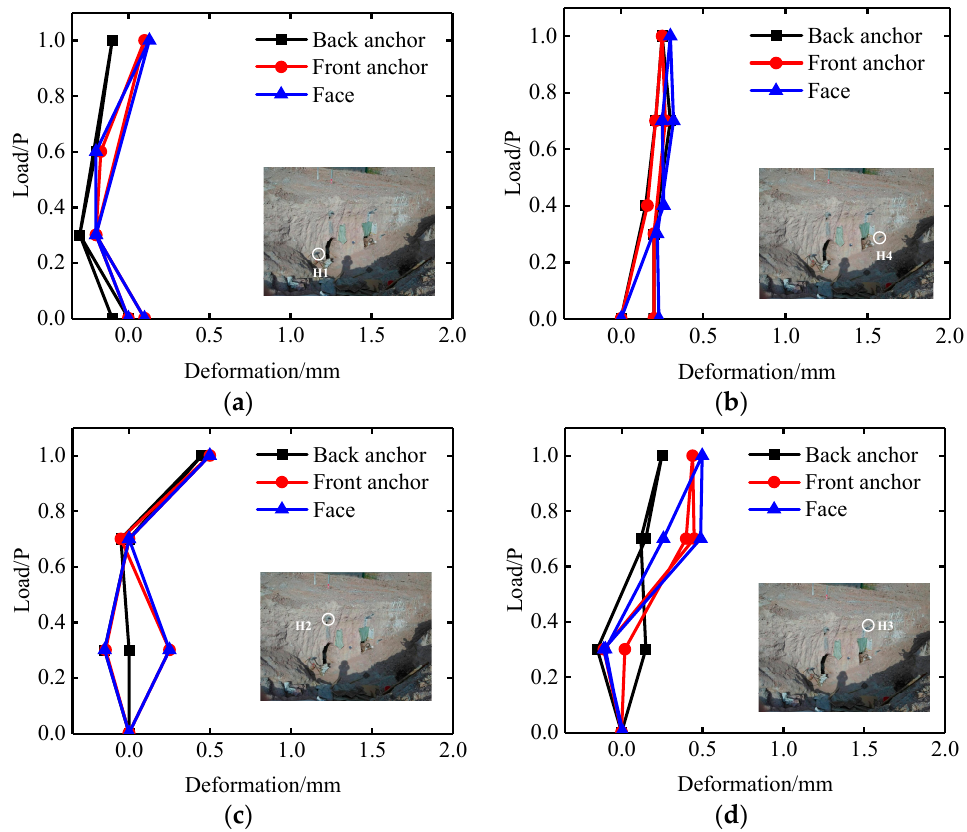
Figure 6. Design load deformation test results of sliding micrometer for surrounding rock outside anchorage tunnel: ( a ) H1; ( b ) H4; ( c ) H2; ( d ) H3.